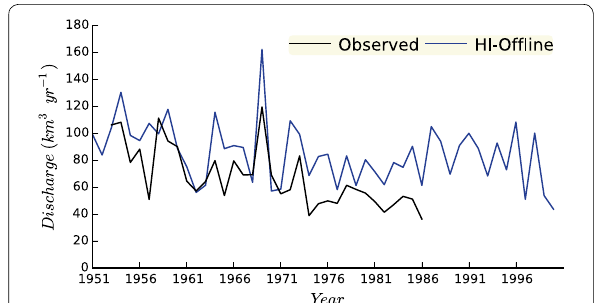
Fig. 1 Comparison of the combined annual river discharge from Amu Darya and Syr Darya rivers at Kerki and Tyumen Aryk sta- tions, respectively, from the model ( blue ) and observations ( black ). Observed data are shown only for the period